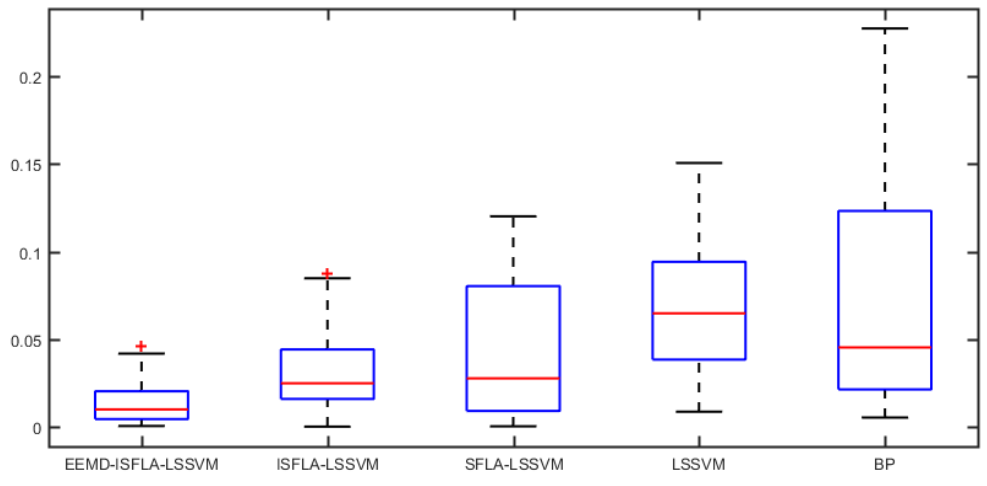
Figure 10. The boxplot for five models. Table 3. The calculation